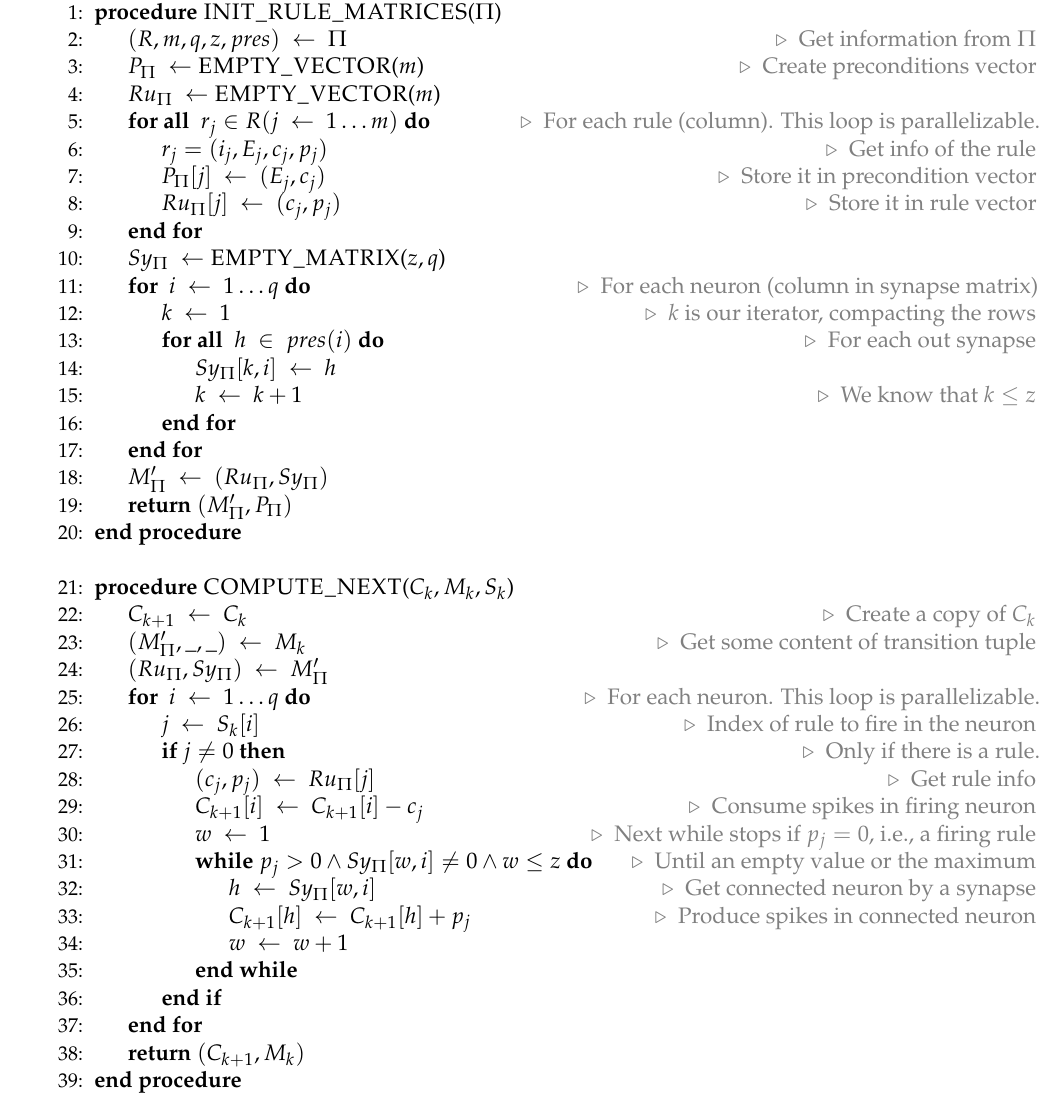
Algorithm 6 Functions for static SNP systems with optimized compressed matrix repre-